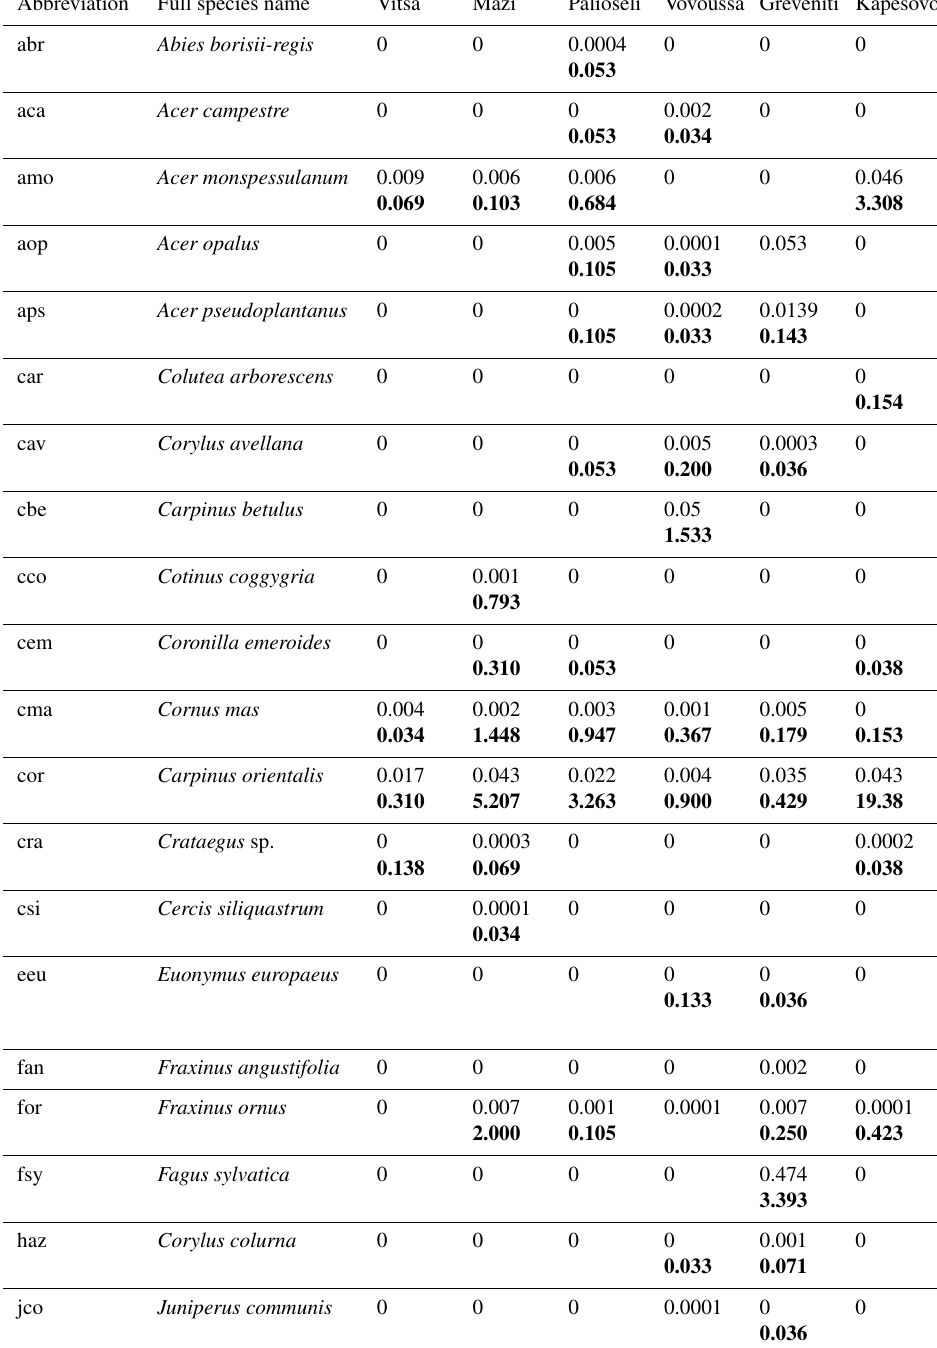
Table K1. Species recorded in the sample plots: Latin scientific name, abbreviation used in the study, and average plot basal area (m 2 ) (average subplot number of understory trees) for each of the studied sacred forests. The average basal area is presented in plain text, while the average number of understory trees is shown in bold. If a species has both values, it means that it was found at both plot and subplot levels. Four species were sampled only at sub-subplot level. These are Arbutus unedo , Calicotome villosa , and Ulmus minor in the Mazi sacred forest and Juglans regia in the Greveniti sacred